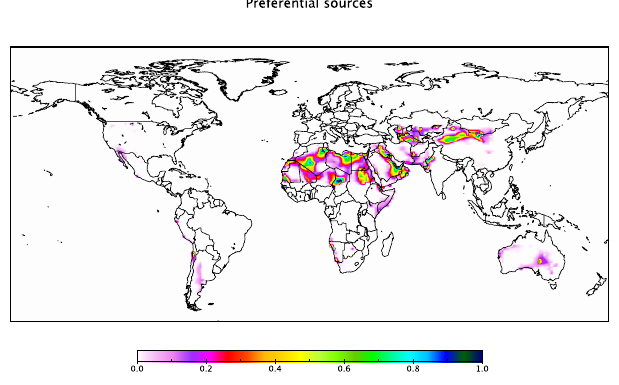
Fig. 1. Preferential sources in the model. The resolution of the map is 1.4 ◦ × 1 ◦ which is used for the global simulation in Sect.